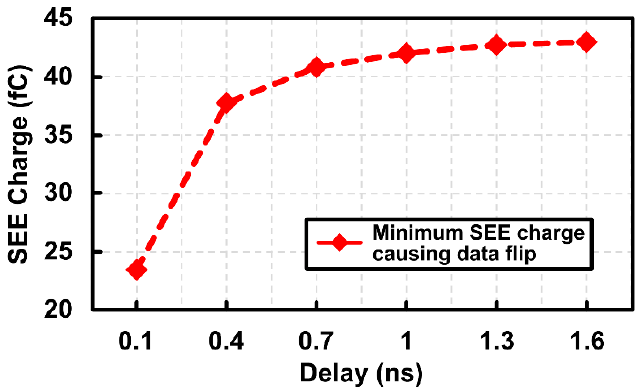
Figure 7. Simulated SEE charge ( Q flip ) causing data flip in the proposed flip-flop vs. delay.